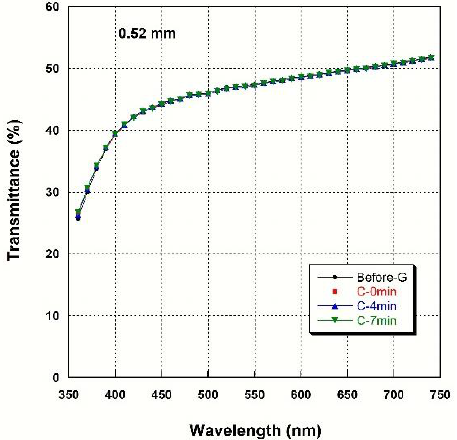
Figure 2. Spectral transmittance curves for various cooling rates at a thickness of 0.52 mm.